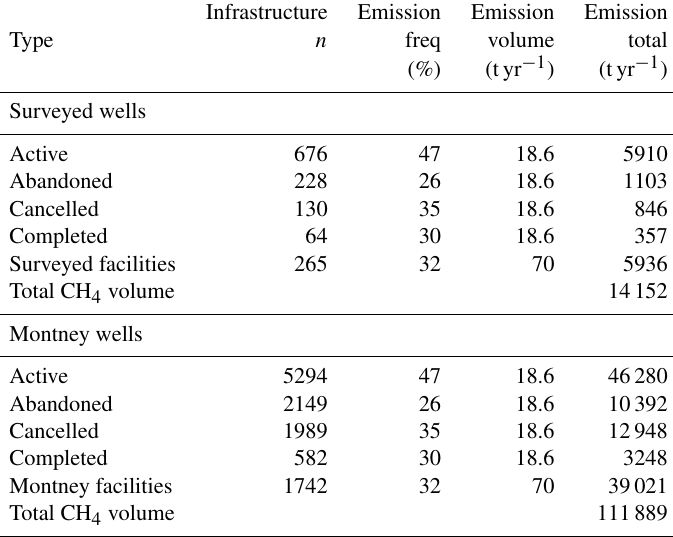
Table 2. Emission volume calculations for all surveyed infrastructure and extrapolated to account for all wells and facilities within the BC portion of the Montney formation. Our minimum detection limit of 0.59 gs − 1 was used as the emission factor for wells. Facility emission volumes are from Omara et al. (2016) because our sampling from facilities was probabilistic due to emission height